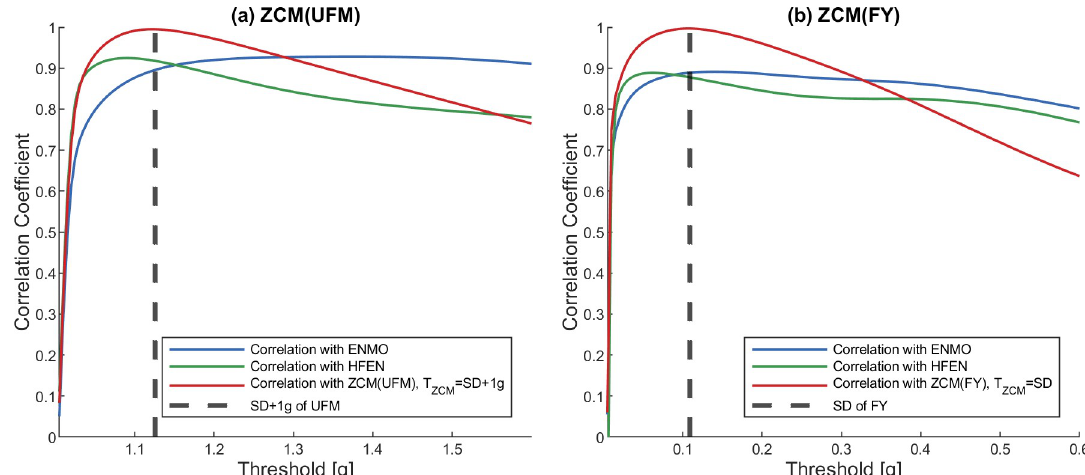
Fig 5. Correlation between ZCM activity signal and activity signals based on other metrics using different TZCM thresholds in the case of UFM (a) and FY (b) datasets. The datapoints of the correlation curves as well as the SD of the datasets were based on the mean of 42 measurements. On each panel, the correlation curves show the Pearson’s correlation coefficients between the ZCM activity signals calculated with the given TZCM threshold value (x-axis) and the ENMO activity signal, the HFEN activity signal, the ZCM activity signal calculated using the SD+1 g (a) or SD (b) of the dataset as threshold.